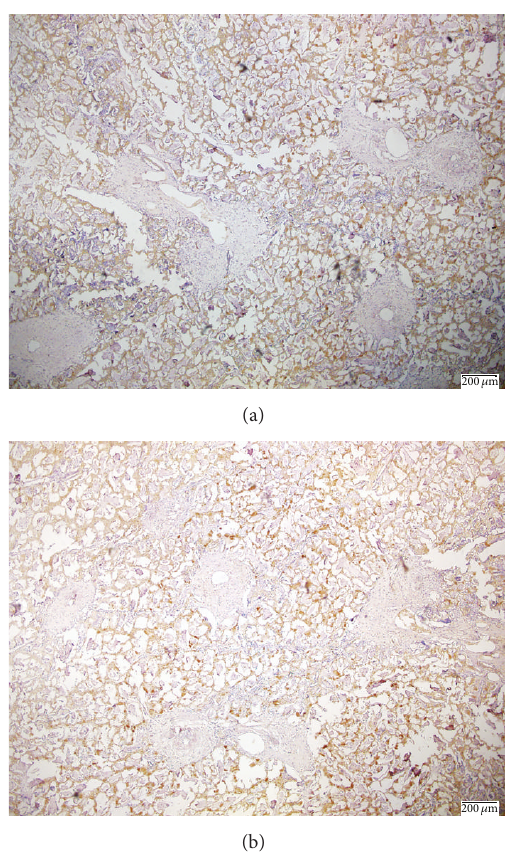
Figure 4: CD31 immunohistochemical staining of specimens 10 weeks after implantation (magnification × 20): the arteriole-like vessels can be seen, (a) from group A, (b) from group B.